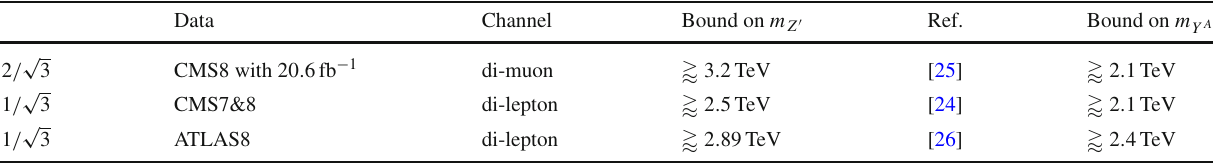
Table3 Summaryoflowerboundson m Z (cid:5) for3-3-1modelswithexotic leptons obtained using ATLAS or CMS data at 7 and 8TeV. Exotic fermion contributions to the Z (cid:5) total width are neglected, except for Ref. [24] where m F = 1TeV is assumed for all exotic fermions. In